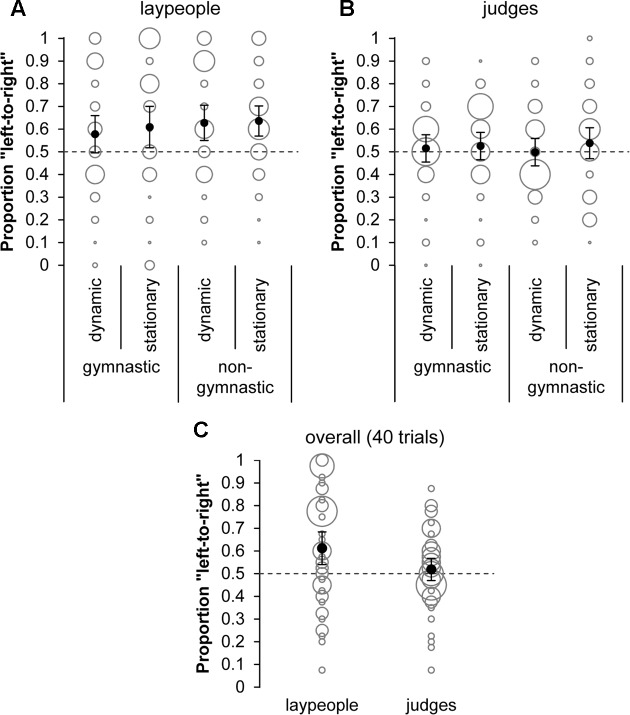
Proportion of pictures selected with a person’s left-to-right orientation relative to random selection (0.50; dotted line) separately for action element conditions in (A) laypeople and (B) judges and (C) overall (i.e., all trials) in laypeople and judges. Means are indicated by black dots and error bars illustrate two-sided 95% confidence intervals of the means. Gray bubbles represent single proportions with the size of bubbles indicating the frequency with which single proportions were observed.